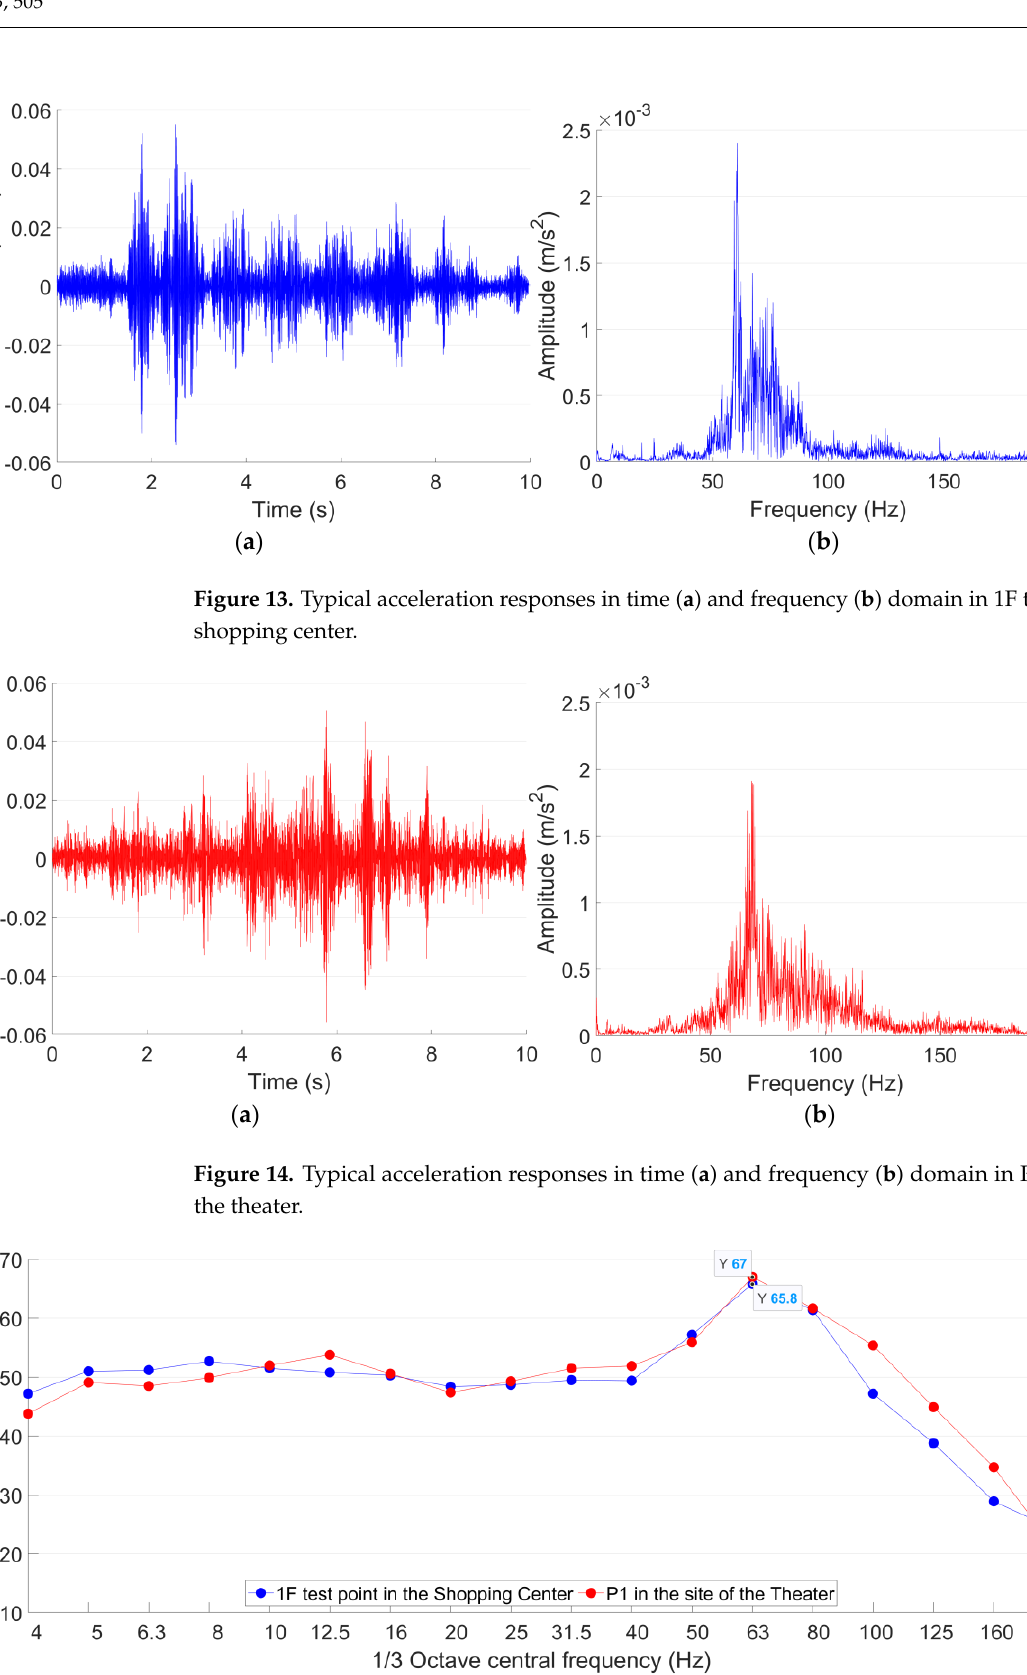
Figure 15. Comparison of 1/3 octave frequency division vibration acceleration level in 1F test point in the shopping center and P1 in the site of the theater.